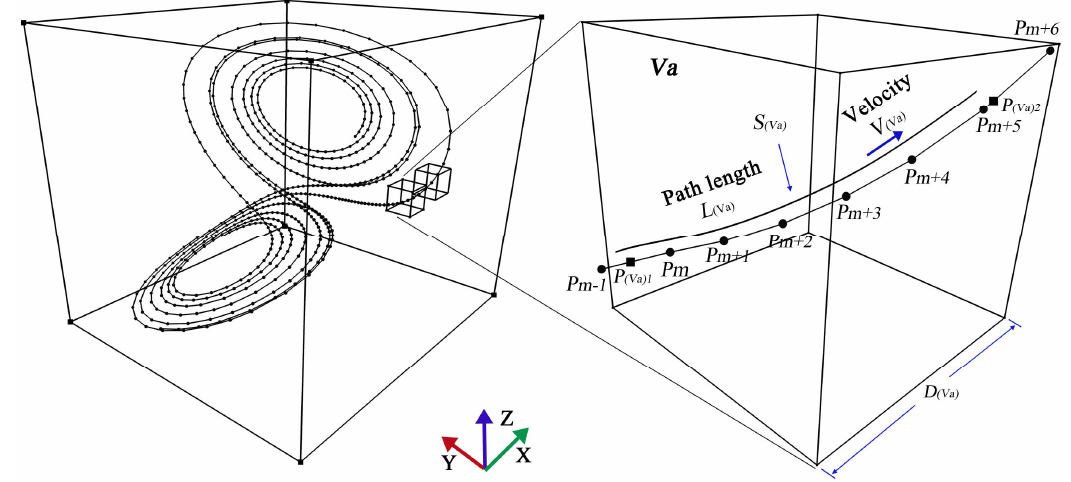
Figure 1. Basic principle of time density estimation. Some points and trajectories (polylines) of the Lorenz model is displayed in the data cube.